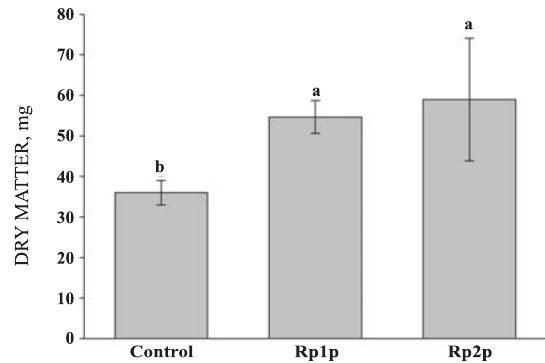
Figure 3. Effect of inoculation of plant-growth- promoting bacteria on L. albescens plants, 40 days after emergence. Different letters indicate significant values at p = 0.05 in the Tukey